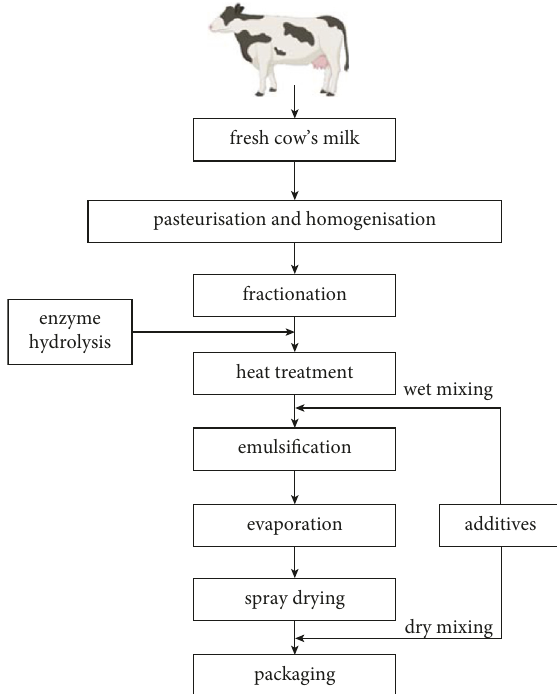
Figure 1: The process of infant milk formula